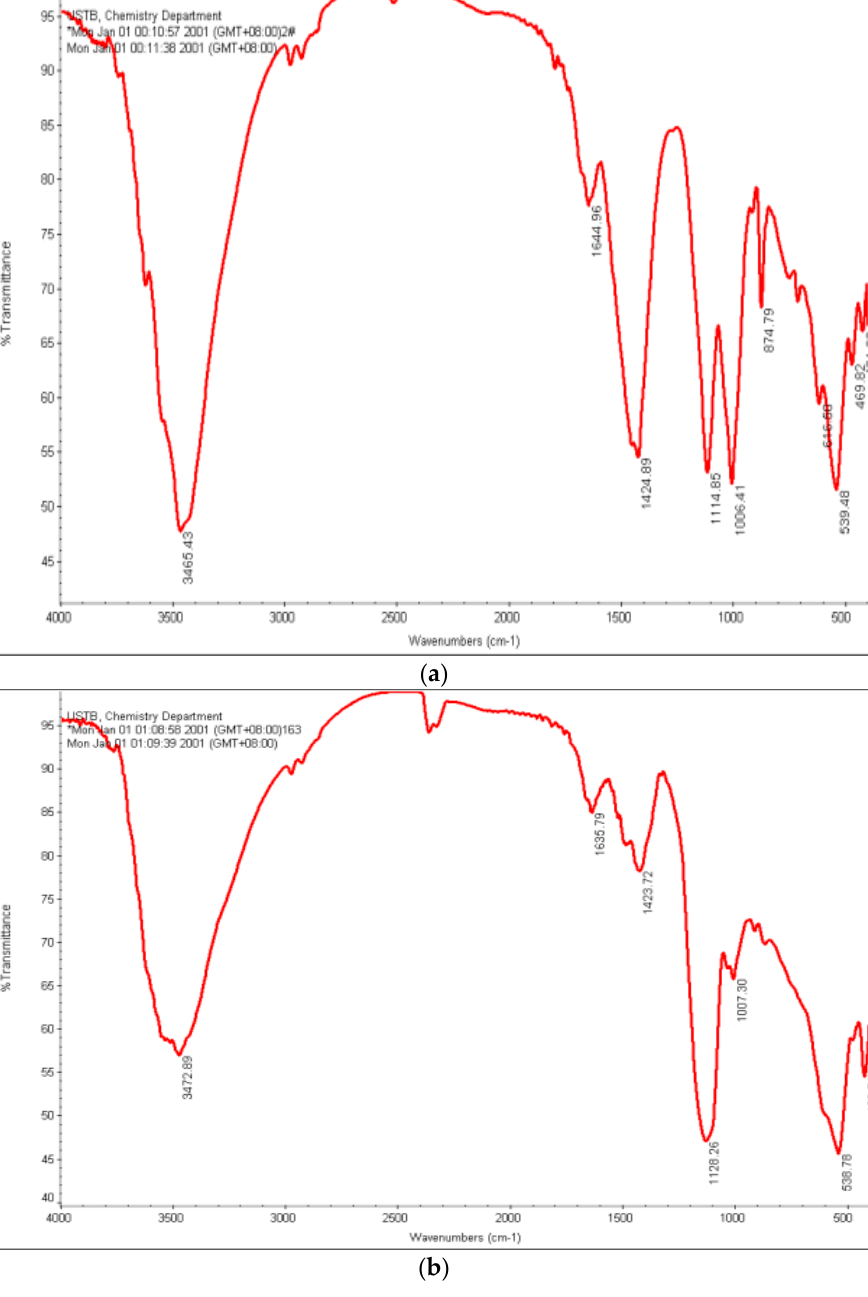
Figure 9. IR spectra of 1 day hardened filling slurry: ( a ) With special additive; ( b ) Without special additive.